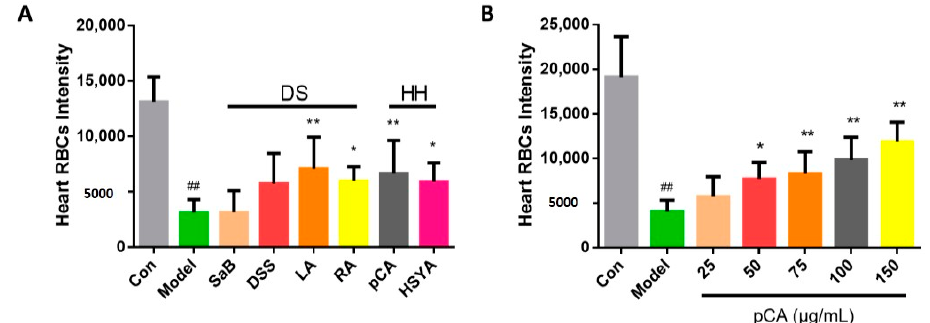
Figure 4. Heart red blood cells intensity in the zebrafish of the control group, model group (AA 40 μ M), and compounds of DHI groups (100 μ g/mL) ( A ) and the p-coumaric acid levels of different concentration groups; ( B ) The error bars represent standard deviation based on ten repeated samples. All data was represented by the mean ± SD, ## p < 0.01, ** p < 0.01, * p < 0.05 ( n = 10). SaB, DSS, LA, RA, pCA and HSYA stand for salvianolic acid B, danshensu, lithospermic acid, rosmarinic acid, p-coumaric acid and hydroxysafflor yellow A, respectively.